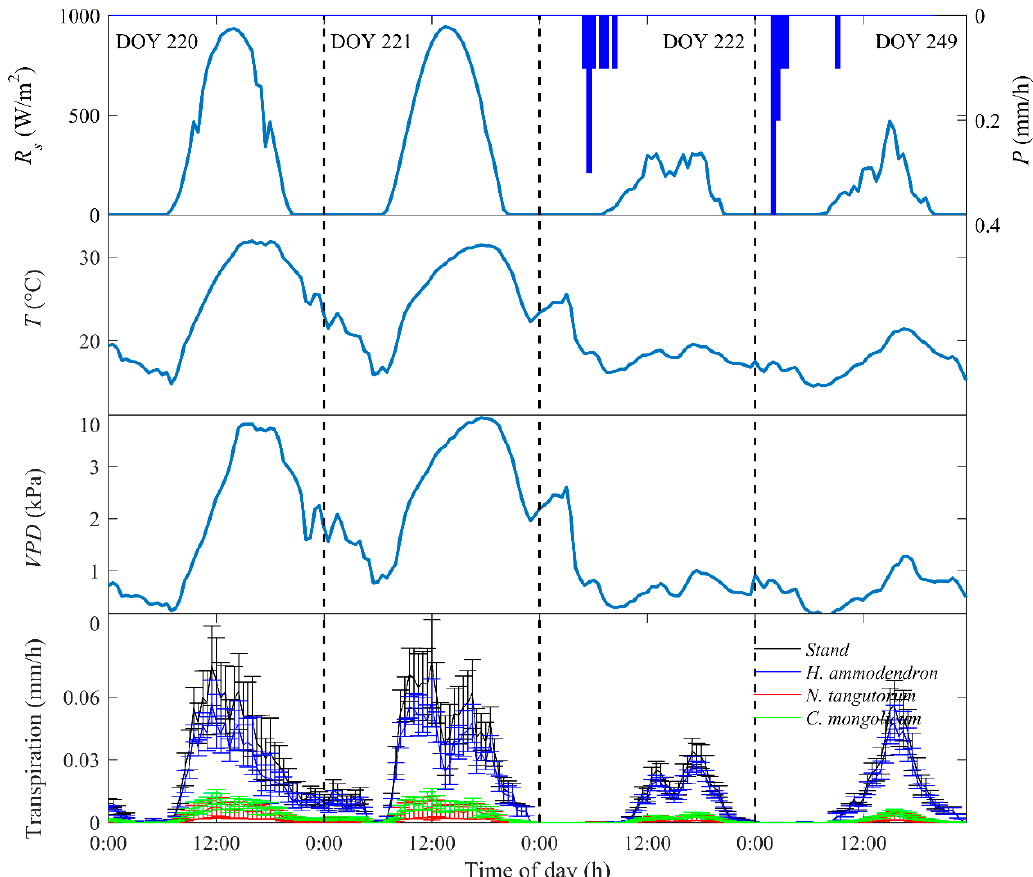
Figure 2. Diurnal courses of half-hourly solar radiation ( R s ), air temperature ( T ), vapor pressure deficit ( VPD ), precipitation ( P ), and transpiration for typical sunny days (DOY 220 and 221) and rainy days (DOY 222 and 249) in 2014.